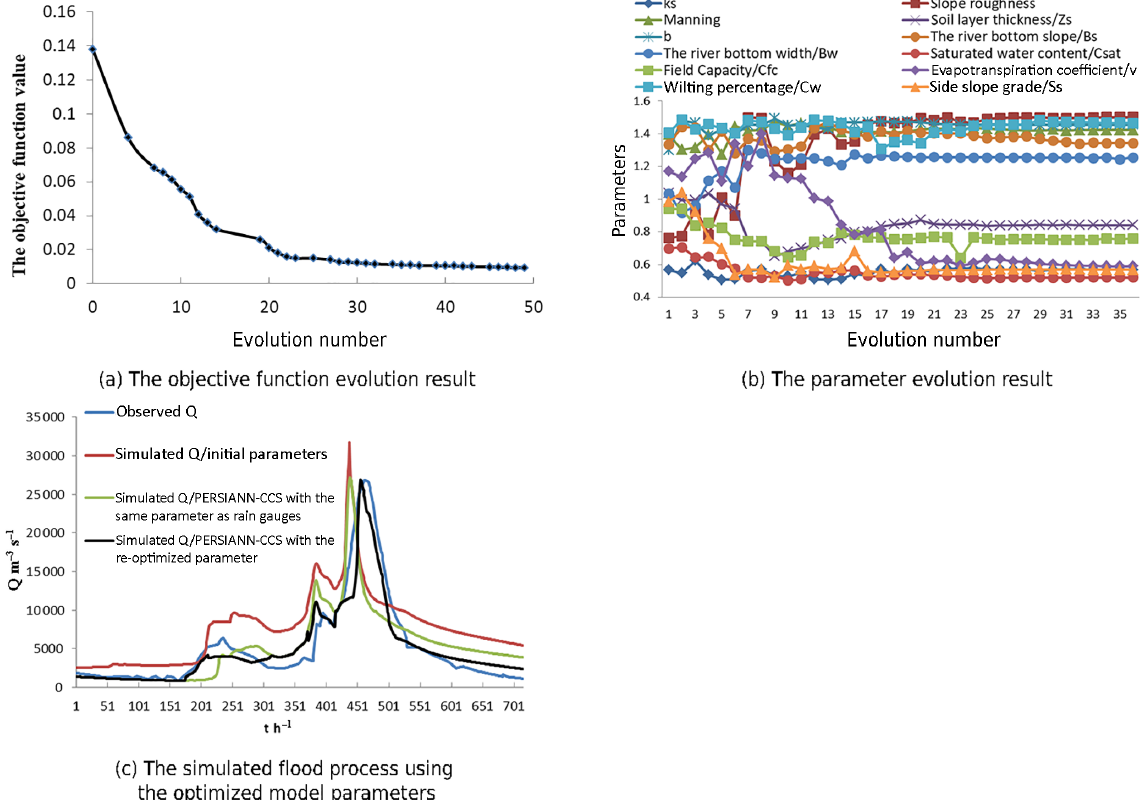
Figure 12. Parameter optimization results with the improved PSO